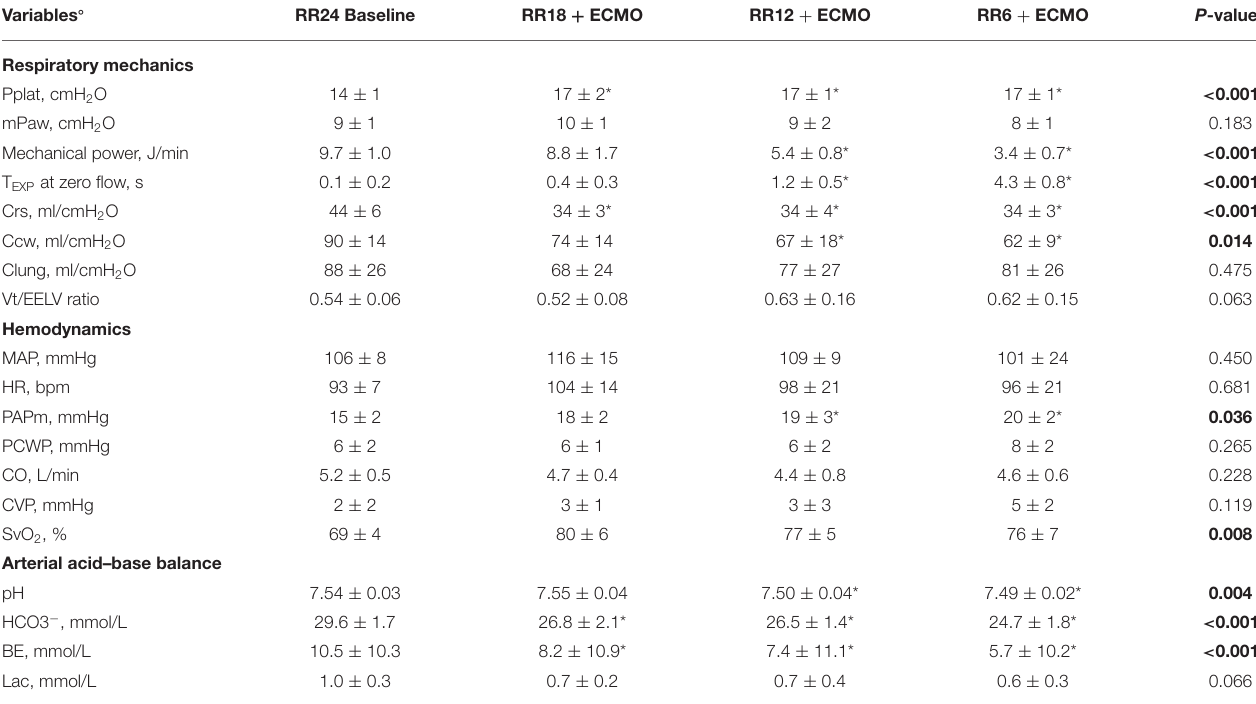
TABLE 2 | Physiological effects of progressive reduction of respiratory rate and increase of extracorporeal CO 2 removal during ECMO support—Part 2. Variables ◦ RR24 Baseline RR18 + ECMO RR12 + ECMO RR6 +